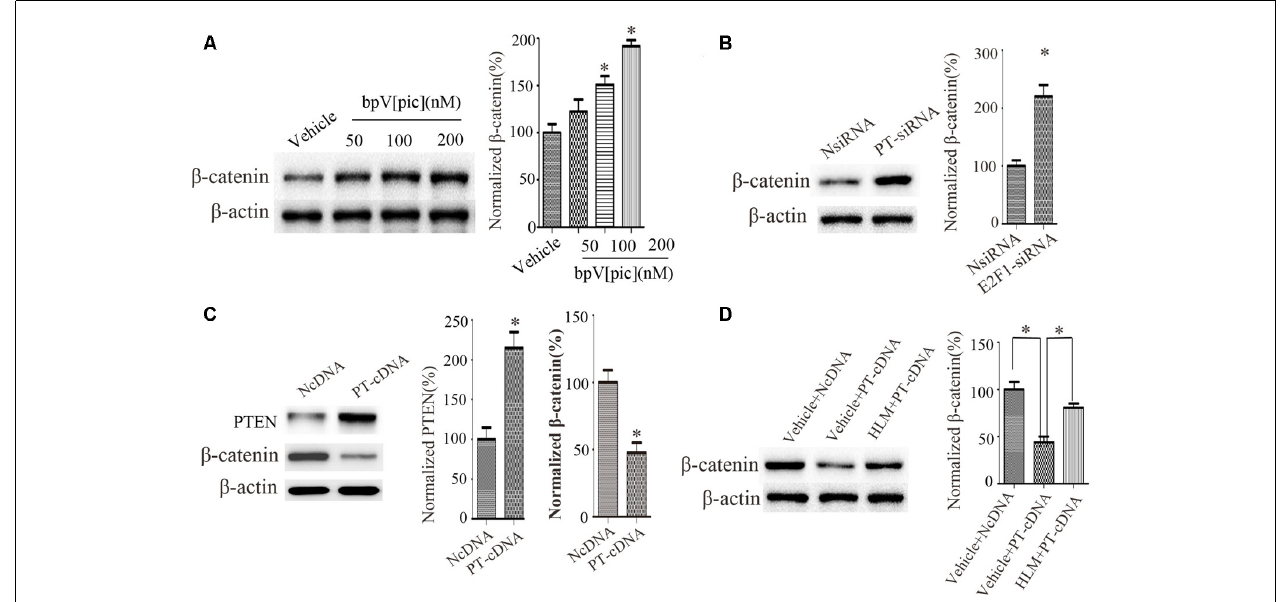
FIGURE 5 | PTEN downregulated β -catenin, and this depended on E2F1 in primary cortical neurons. (A) Western blot showed that bpV[pic] increased β -catenin expression in a dose-dependent manner in primary cortical neurons ( ∗ p < 0.05 compared to Vehicle, one-way ANOVA test, followed by Bonferroni post hoc test). (B) The expression of β -catenin was increased when PTEN siRNA was transfected in primary cortical neurons for 24 h ( ∗ p < 0.05 compared to NsiRNA, Student’s t -test). (C) The expression of β -catenin was decreased when PTEN was overexpressed in primary cortical neurons for 24 h ( ∗ p < 0.05 compared to NcDNA, Student’s t -test). (D) Western blot showed that E2F1 inhibitor HLM006474 attenuated the PTEN overexpression-induced downregulation of β -catenin when pretreated with HLM006474 for 12 h before overexpressing PTEN in neuronal cells ( ∗ p < 0.05, one-way ANOVA test, followed by Bonferroni post hoc test, N = 8; PT-cDNA, PTEN cDNA; PT-siRNA, PTEN